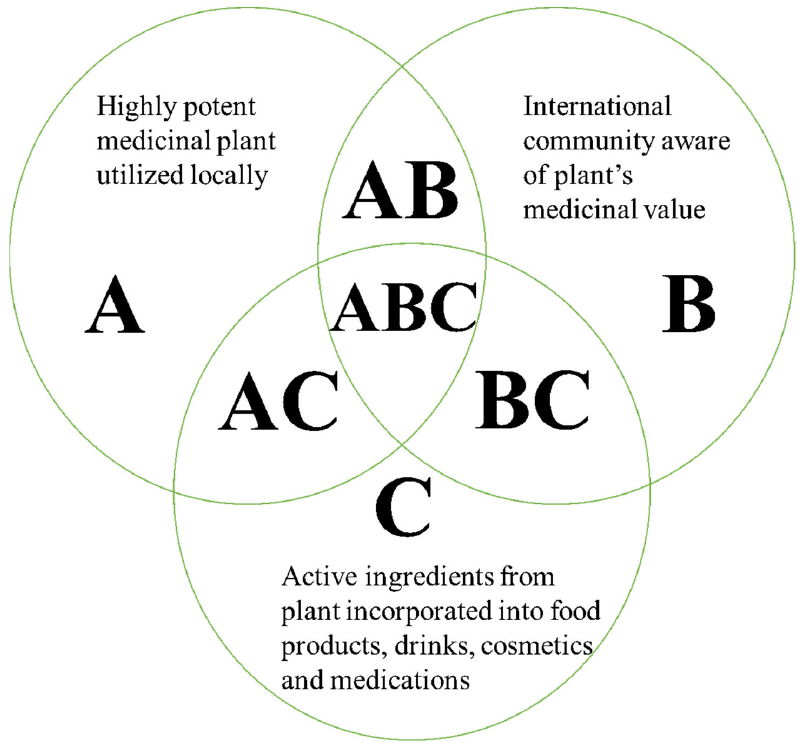
Figure 1. Factors responsible for the propagation of South African indigenous and naturalized medicinal plants.